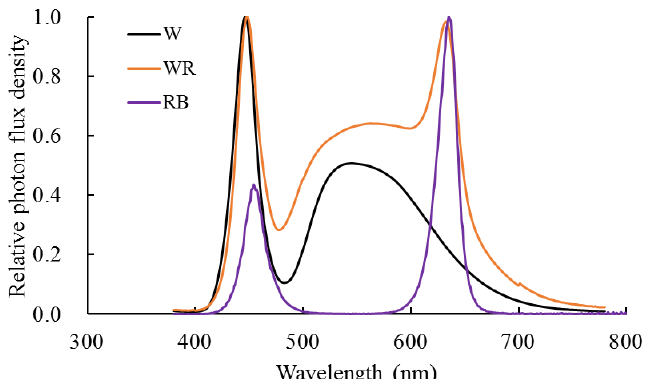
Figure 1. The relative spectral photon flux of white LEDs, white plus red LEDs, and red plus blue LEDs.